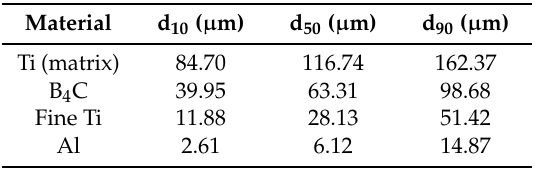
Table A1. Particle size distributions of the starting